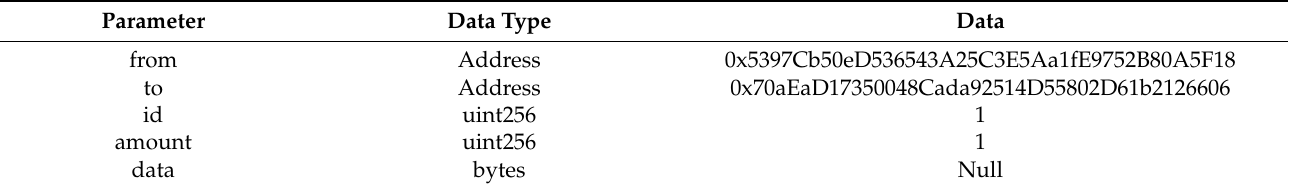
Table 8. Transaction data used in the last scenario.